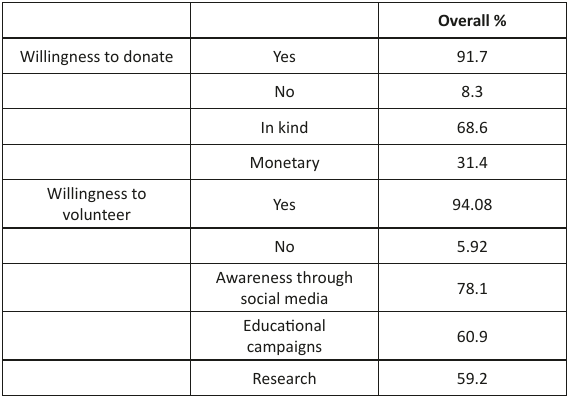
Table 4. Respondents’ answers to participate in conservation activities (N=169).